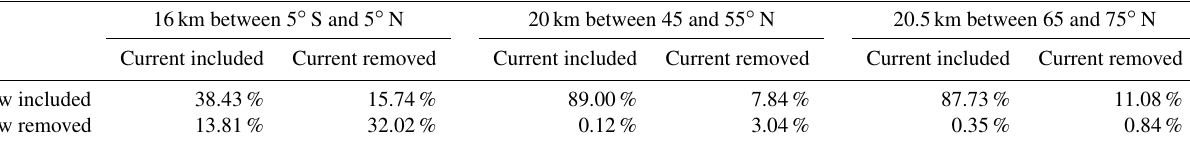
Table 1. Percentage of data removed or included depending on new and current rules.